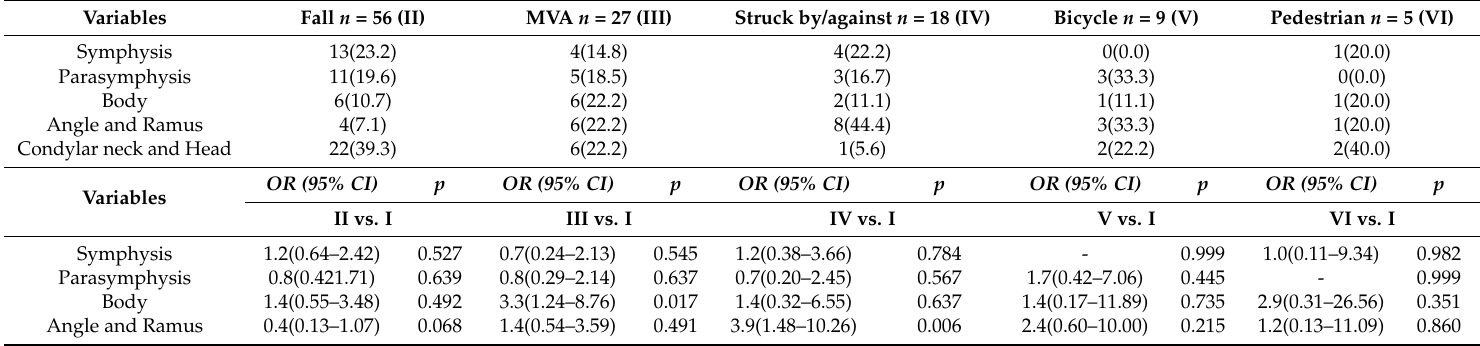
Table 2. The association between cause of trauma and sites of mandibular fractures.